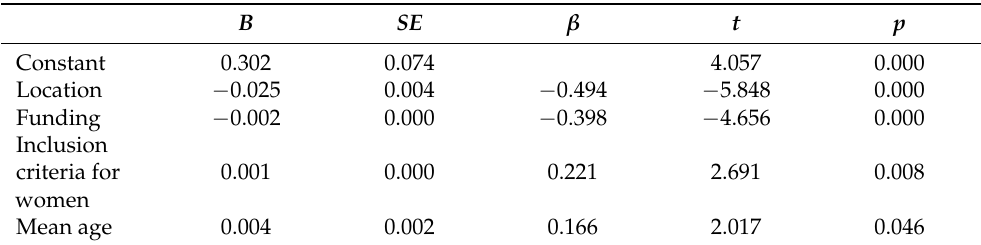
Table 4. Stepwise multiple regression